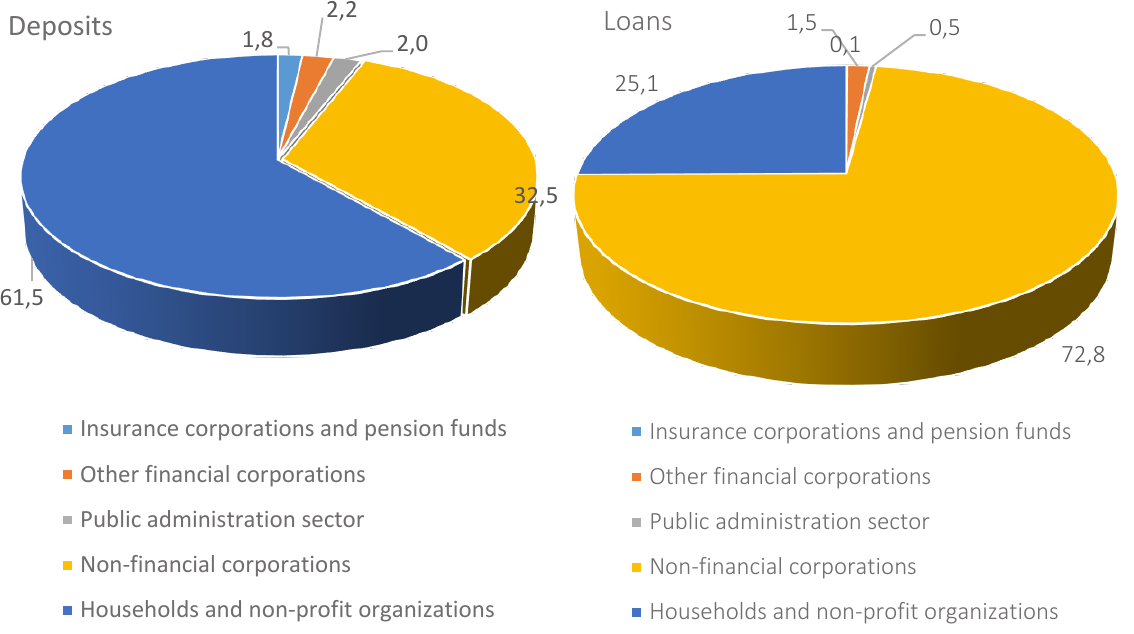
Figure 5. Structure of deposits and loans by economic sectors, the averaged 2007–2019